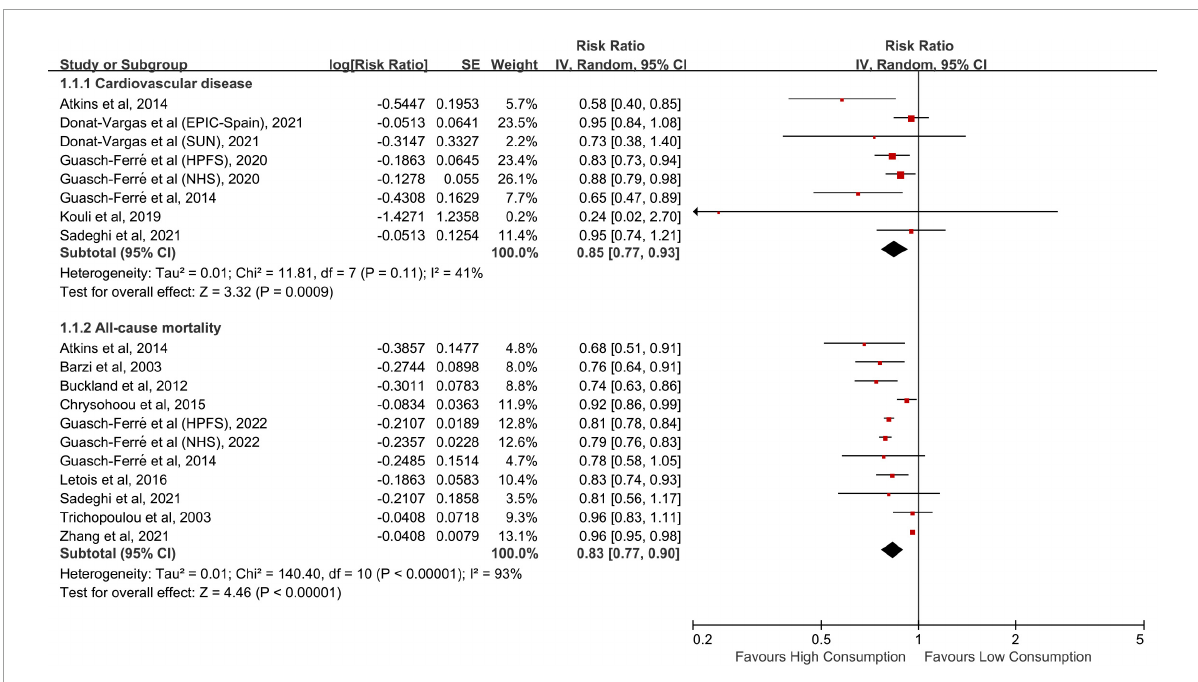
FIGURE2 Meta-analytic results for the highest vs. lowest comparison of olive oil consumption. CI, confidence interval; SE, standard